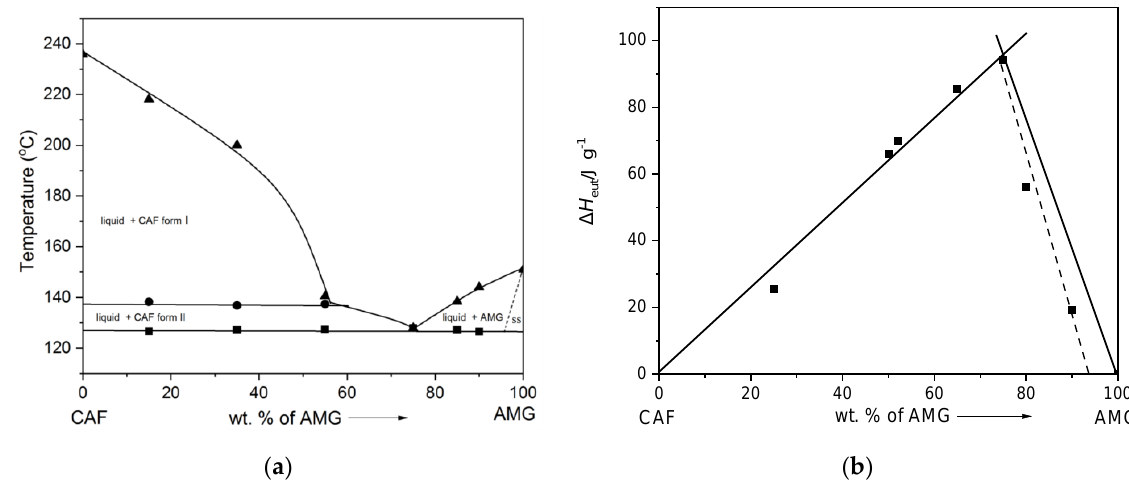
Figure 6. ( a ) Binary melt phase diagram and ( b ) Tammann plot of the AMG-CAF system. AMG-NIC system. The DSC profiles in Figure 3b illustrate the melting behavior of solid samples at different AMG-NIC compositions prepared by neat grinding. The system shows simple eutectic behavior; thus, mixtures of both components exhibit two endothermic peaks in DSC curves corresponding to eutectic melting and the subsequent dissolution effect of the excess compound. Figure 7a presents the derived melt phase diagram with a eutectic composition of ~50 wt.% AMG. The eutectic temperature in this system was found on average at 99.2 °C (Table 1). The Tammann plot shown in Figure 7b confirms the ~50 wt.% eutectic composition.